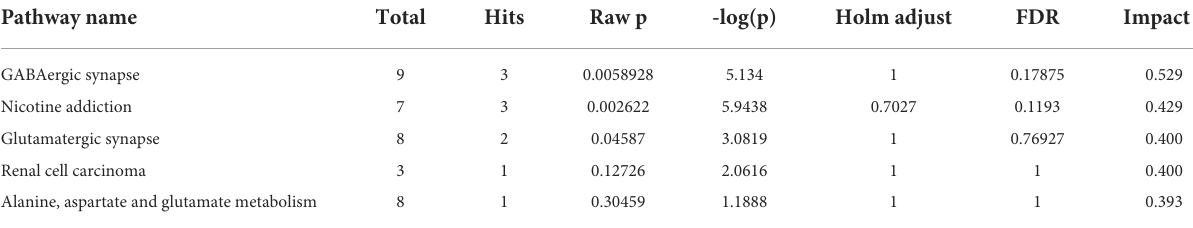
TABLE 2 The top five differential metabolite